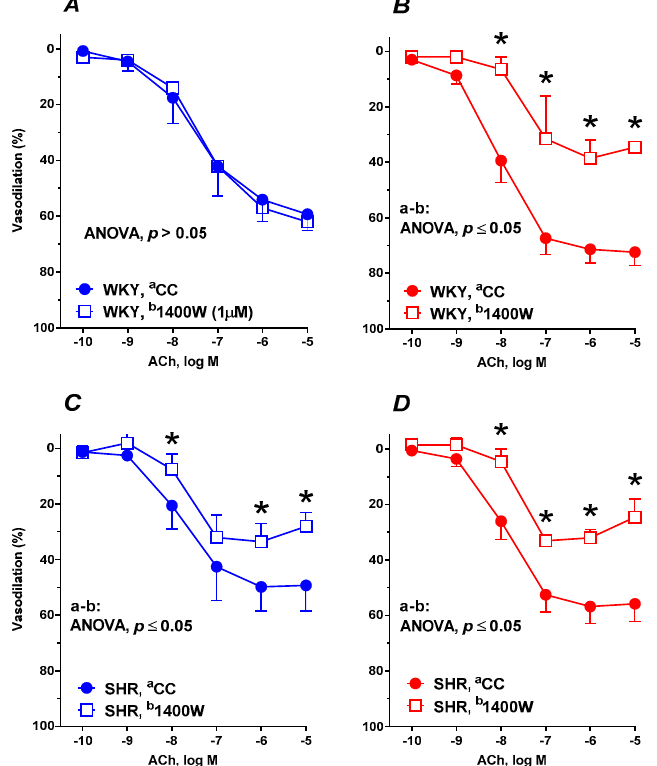
Figure 3. The influence of experimental diets on the vasodilator response to acetylcholine in thoracic arteries isolated from WKYs ( A , B ) and SHRs ( C , D ). From 10 weeks of age, rats were fed a control diet without added raspberry seeds (RBS) ( A , C ) and with a diet supplemented for 6 weeks with added 7% ground RBS ( B , D ). ACh-induced vasodilation was analyzed in the absence and presence of the selective inducible nitric oxide synthase (iNOS) inhibitor (1400W, 1 µ M, 30 min). Results (mean ± SEM) are expressed as a percentage of the inhibition of the contraction induced by noradrenaline (1.5 ± 0.18 g), * p ≤ 0.05 (two-way ANOVA / Tukey’s), m = 6–8.